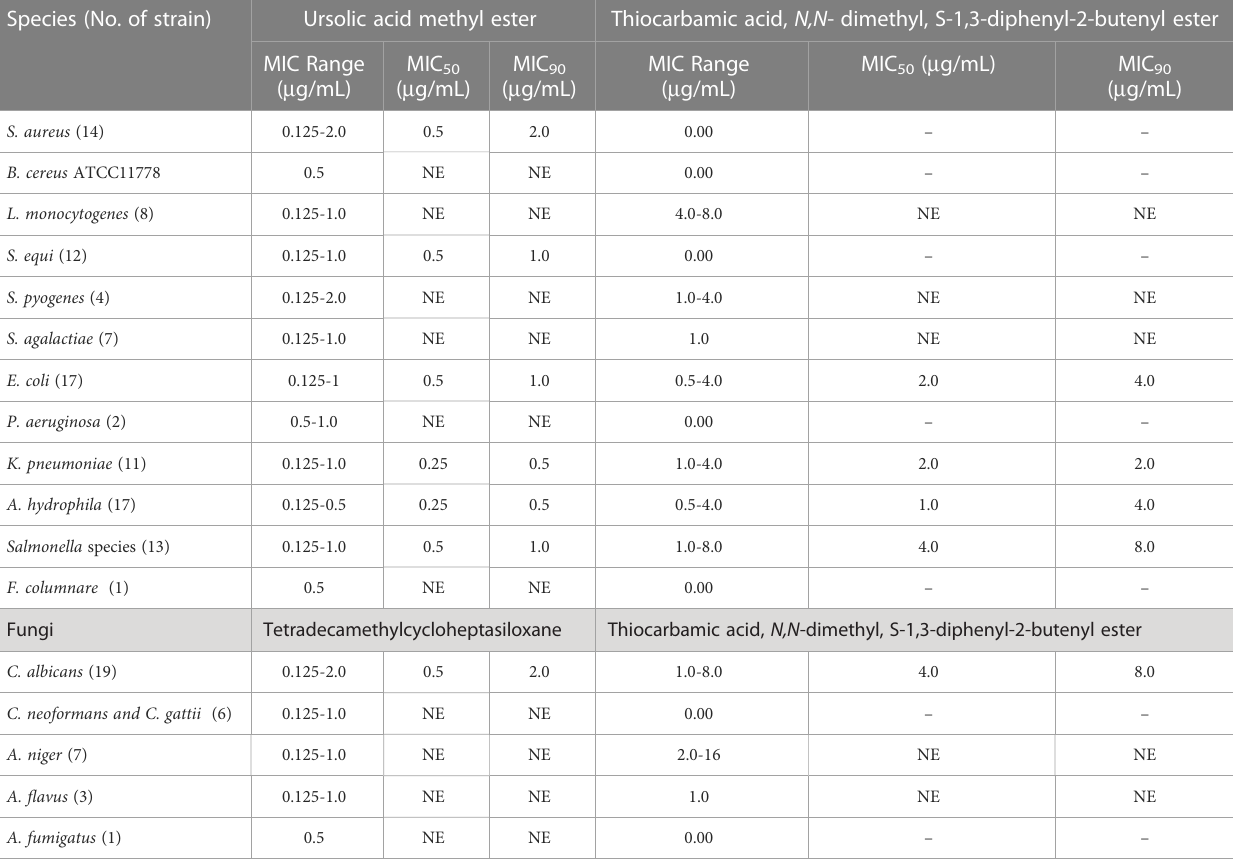
TABLE 1 Antimicrobial activity of bioactive metabolites of S . misakiensis and S. coeruleorubidus.